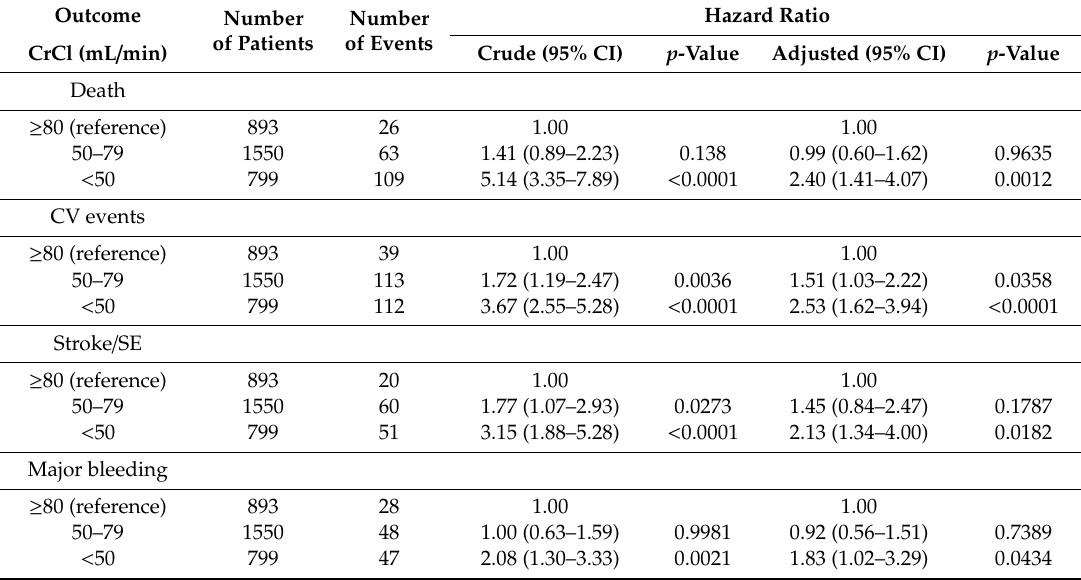
Table 2. Adverse clinical outcomes and results of the Cox proportional hazards model according to the renal